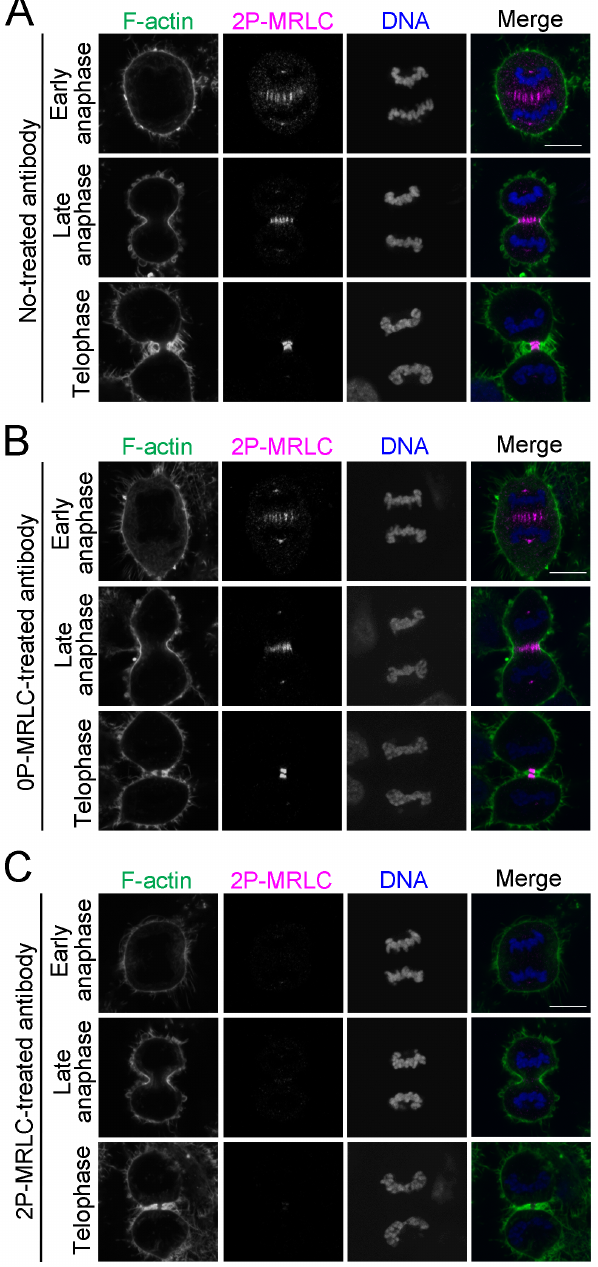
Figure 1. 2P-MRLC localizes to the centrosomal region, contractile ring, midzone, and midbody during cytokinesis. HeLa cells were fixed and immunostained with anti-2P-MRLC mono- clonal antibody (4F12) preincubated with PBS (A), 0P-MRLC (B), or 2P- MRLC (C) at 37 u C for 60 min. Bar, 10 m m.